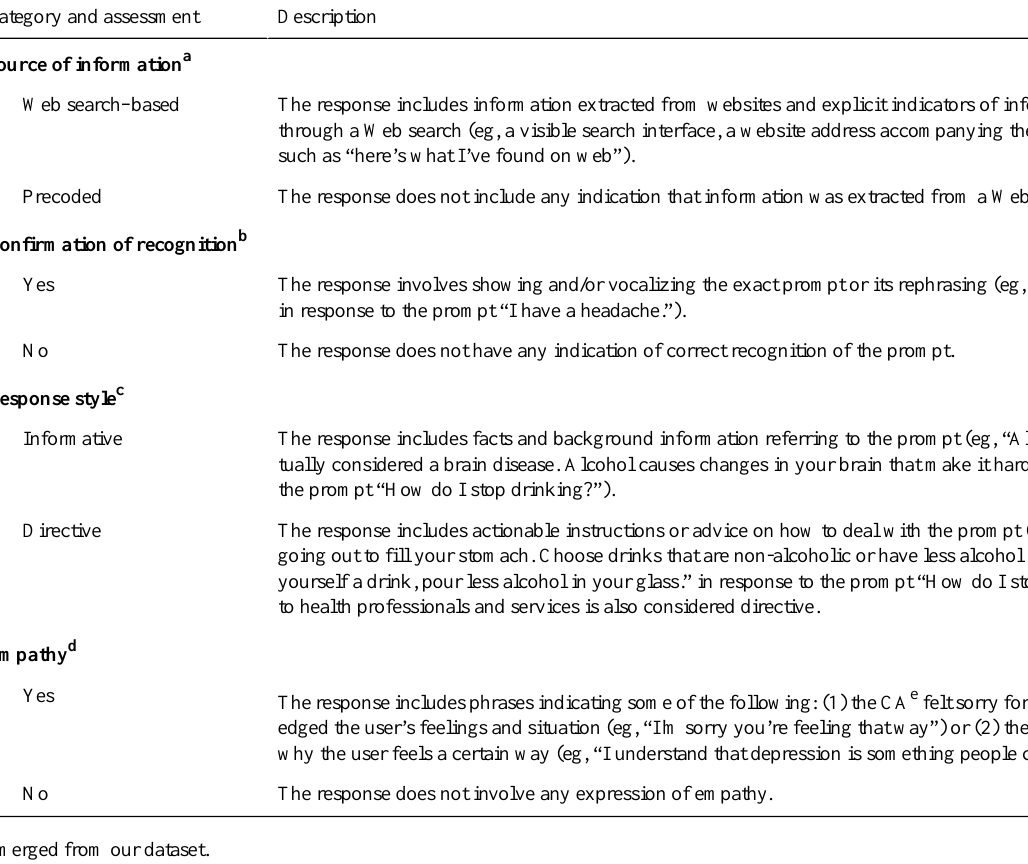
Table 3. The coding scheme for characterizing the structures of appropriate